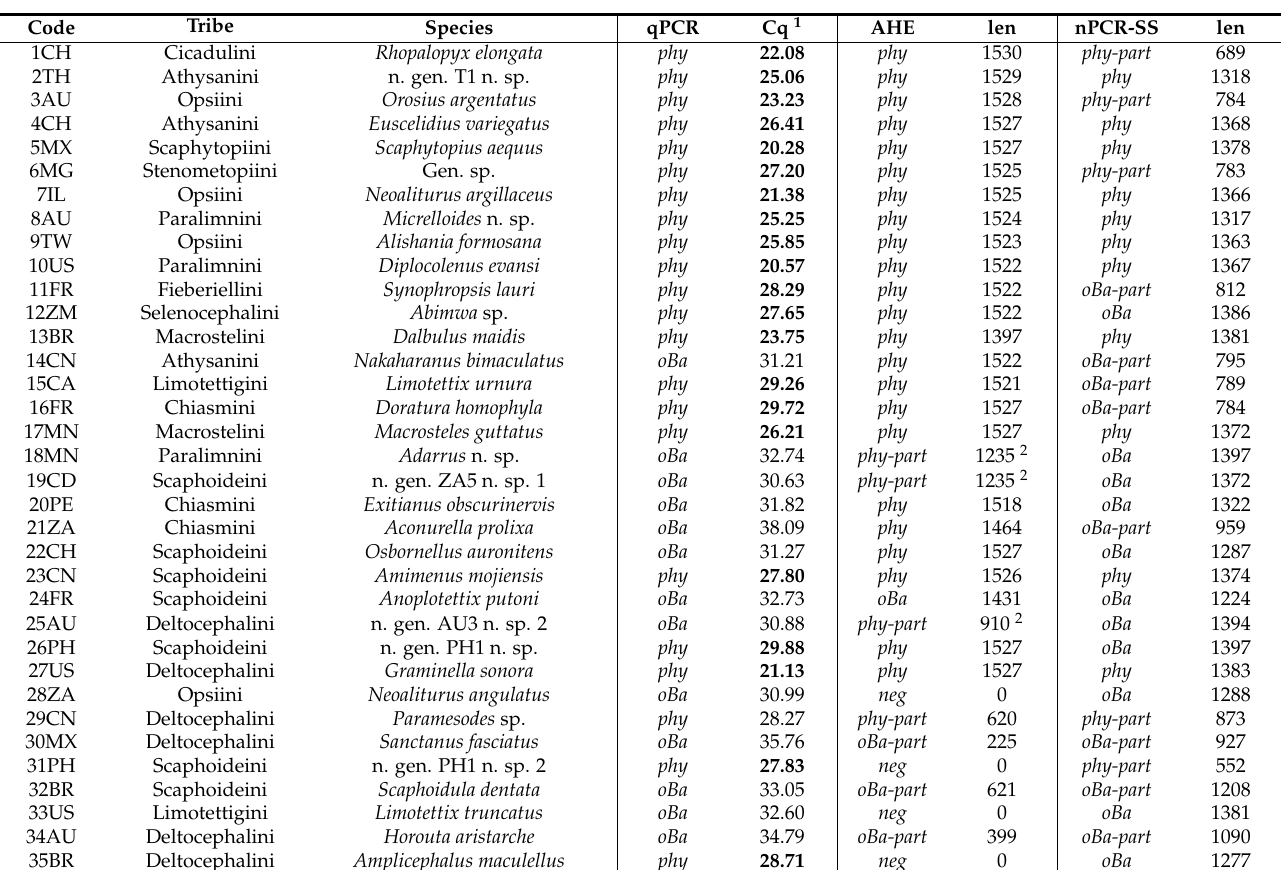
Table 1. List of samples analyzed for the presence of phytoplasmas using AHE, qPCR and nested PCR followed by Sanger sequencing (nPCR-SS) methods. Description of locations and collecting